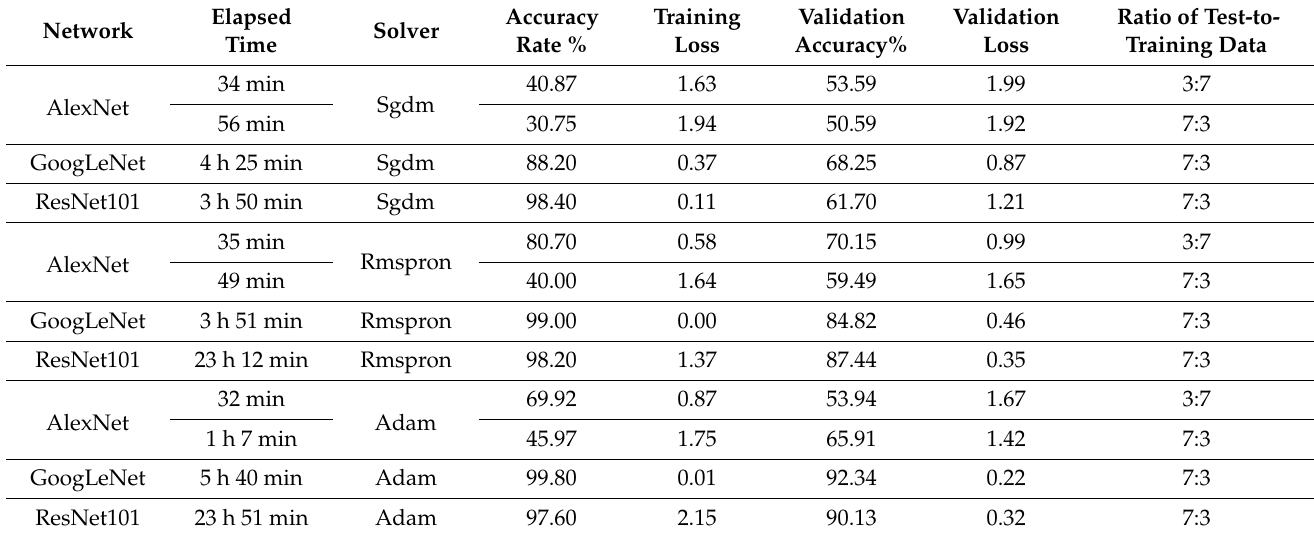
Table 3. Accuracy/validation rate results without FS to carry out the three